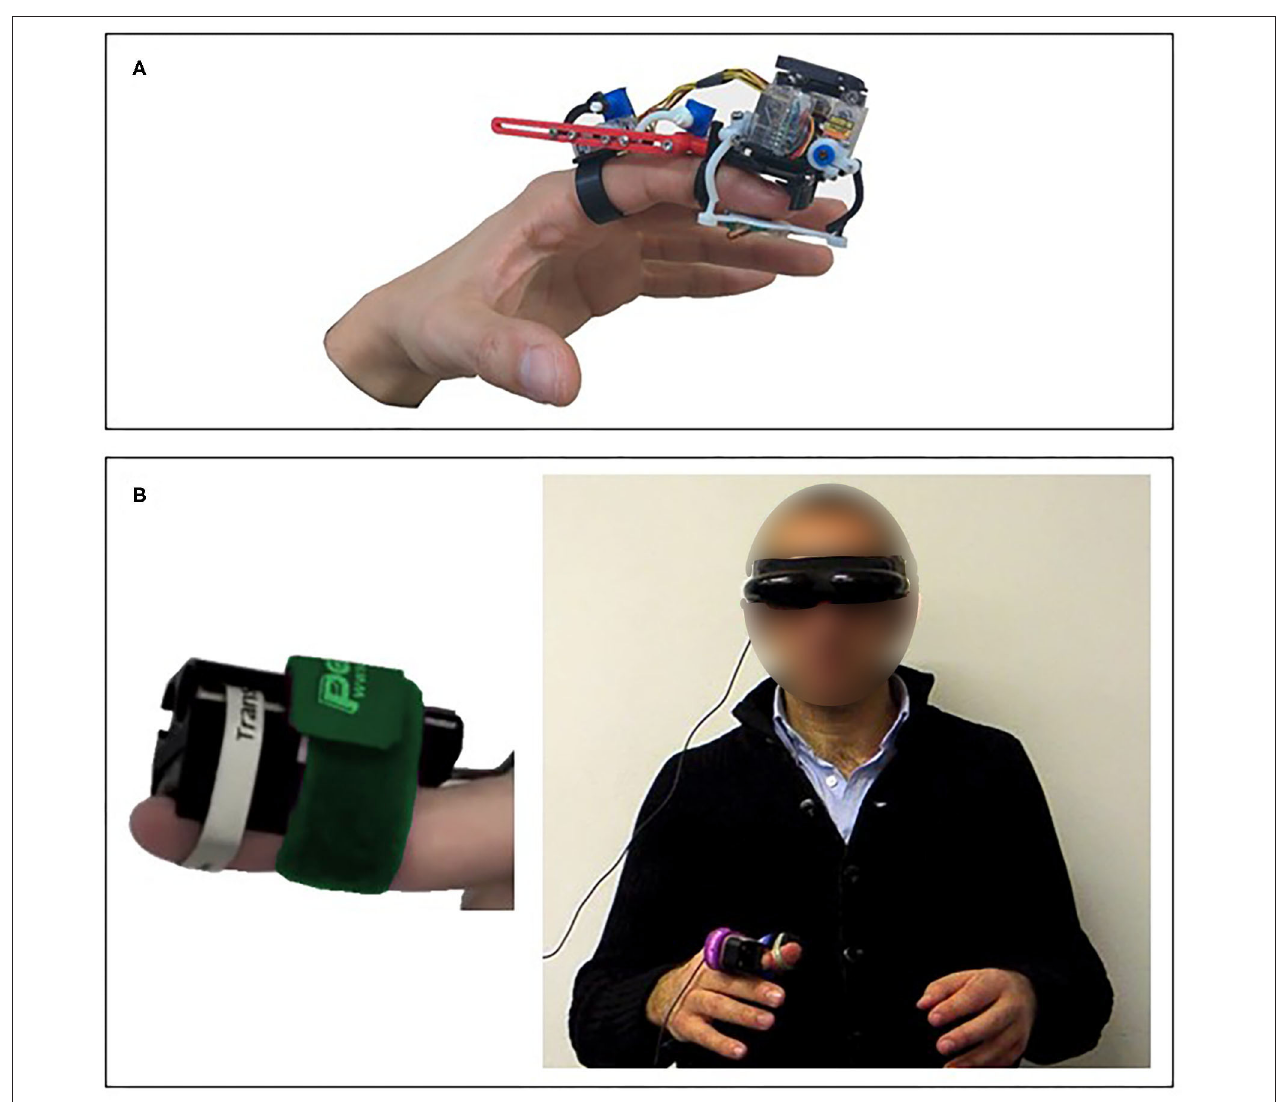
FIGURE 3 | Skin deformation—pressure stimulation devices. (A) A wearable finger device that was designed and tested in virtual reality applications (Chinello et al., 2019). (B) The RemoTouch system that provides experience of remote touch (Prattichizzo et al., 2010).